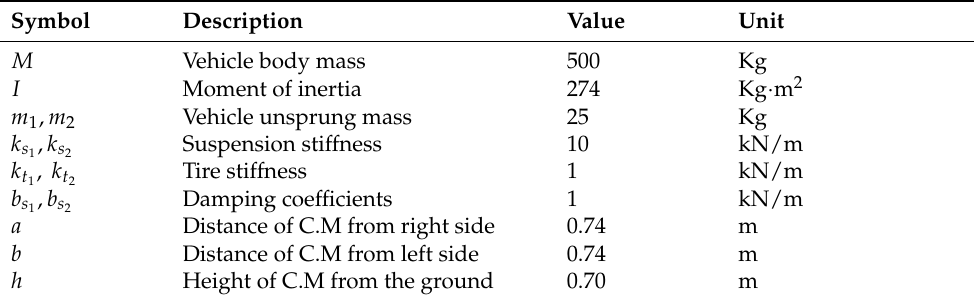
Figure 1. Schematic diagram for a half-car model equipped with aerodynamic surfaces. Table 1. Physical parameters of half-car